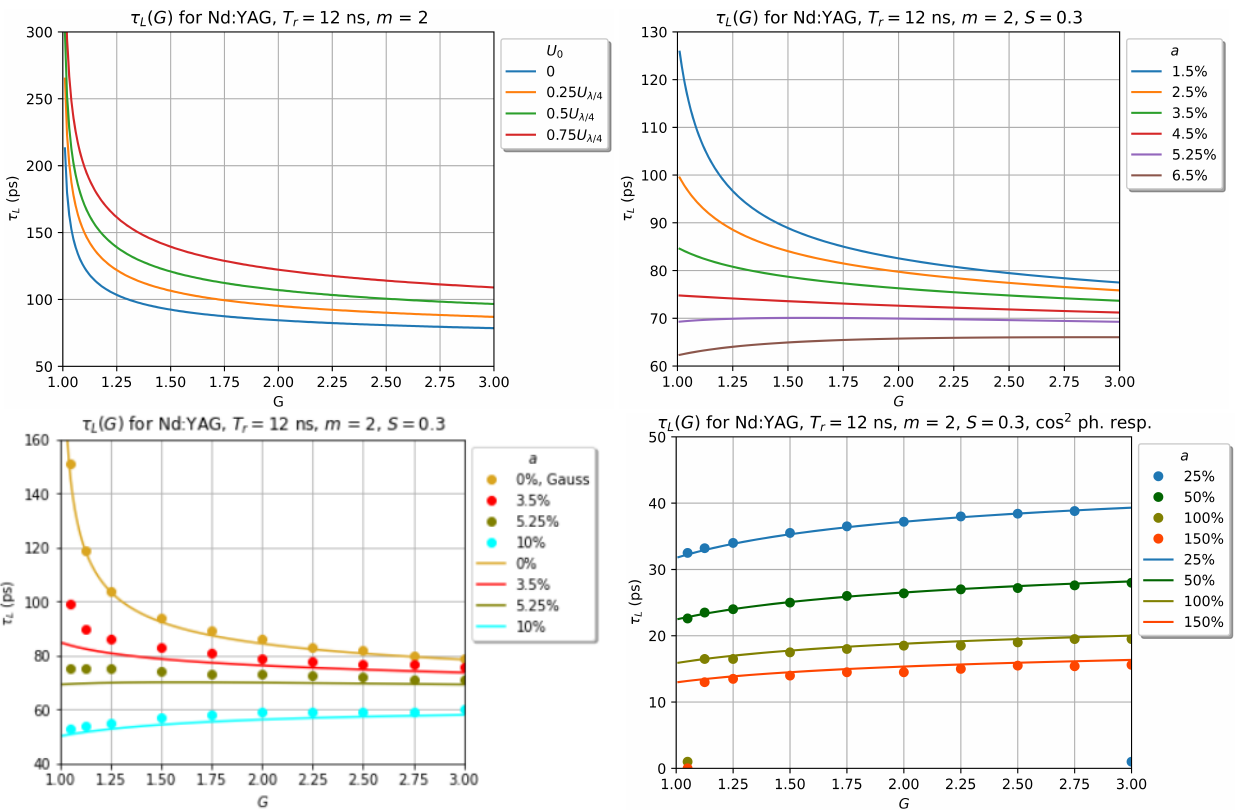
Figure 5. Laser pulse durations τ L and τ LM versus G in the SSHML regime with modulation and with m = 2 pulses per round-trip time T r = 12 ns: formula (solid curves) and numerical simulation (points) (color